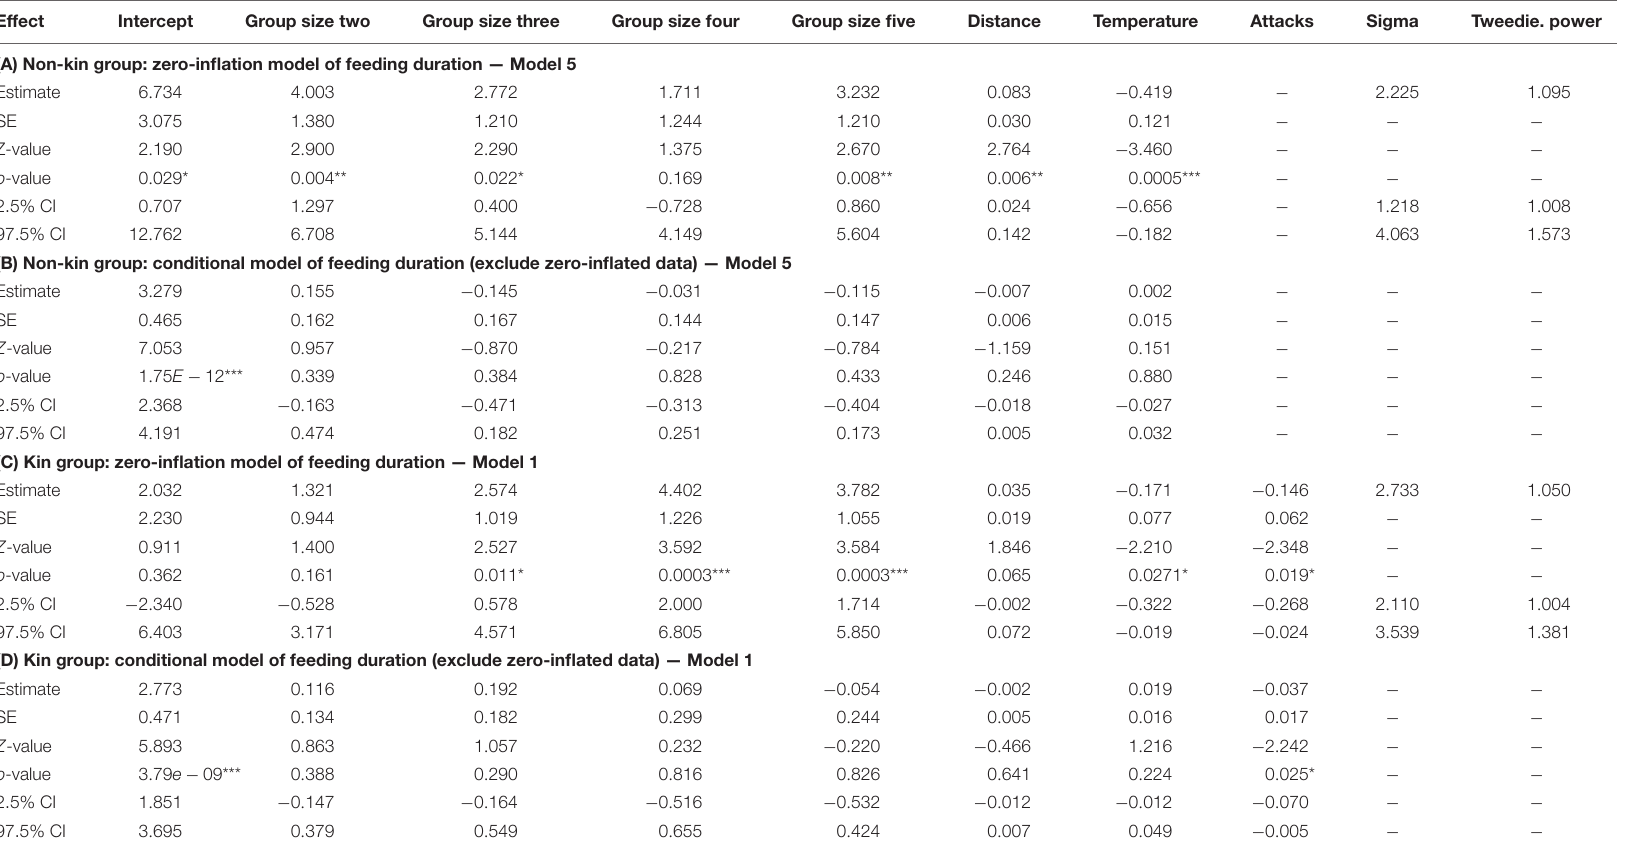
TABLE 1 | The statistical results of feeding duration in response to group size, kinship, distance to the hub, ambient temperature, and host attacks for kin and non-kin groups.